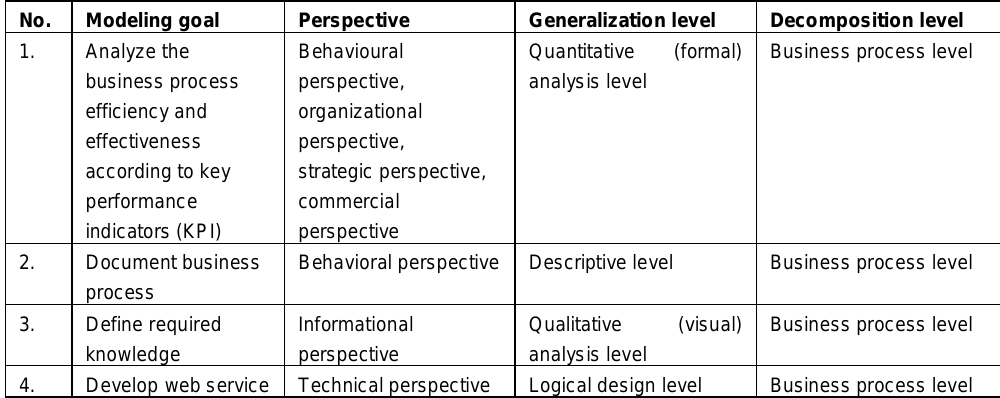
Table 3. The values of parameters of the modeling goals according to the Business Process Modeling